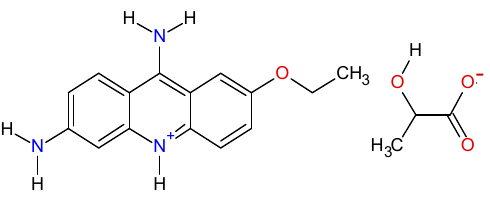
Figure 1. Ethacridine lactate (EL) structure (CAS 1837-57-6; molecular formula: C 18 H 21 N 3 O 4 ; MW = 343.4 g/mol).